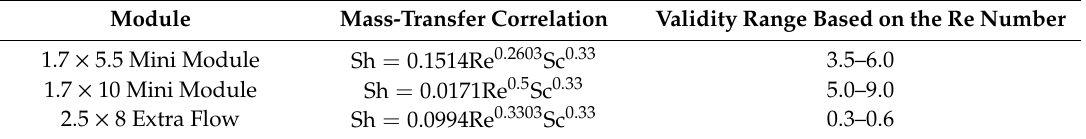
Table 3. Mass-transfer correlations obtained in this study for each HFMC module, under the validity range of the Re